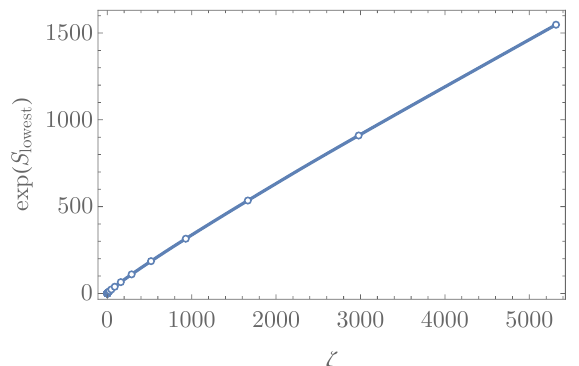
δE 3 / 2 = e S 0 = 1 and 2 φ b = 1 . It 3